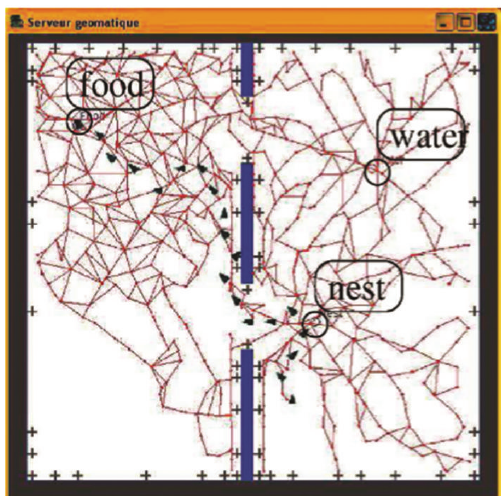
Figure 12: Topographical cognitive map in the form of a graph is produced in the system, as illustrated. Permission for replication given by Dr. Cuperlier et al.